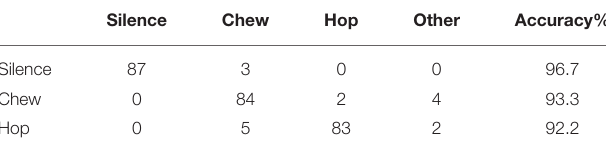
dusk until dawn during full moons compared to new moons TABLE 2 | Confusion matrix of acoustic-based behavioral classification of snowshoe hare behavior to three categories: silence, chew, and hop.